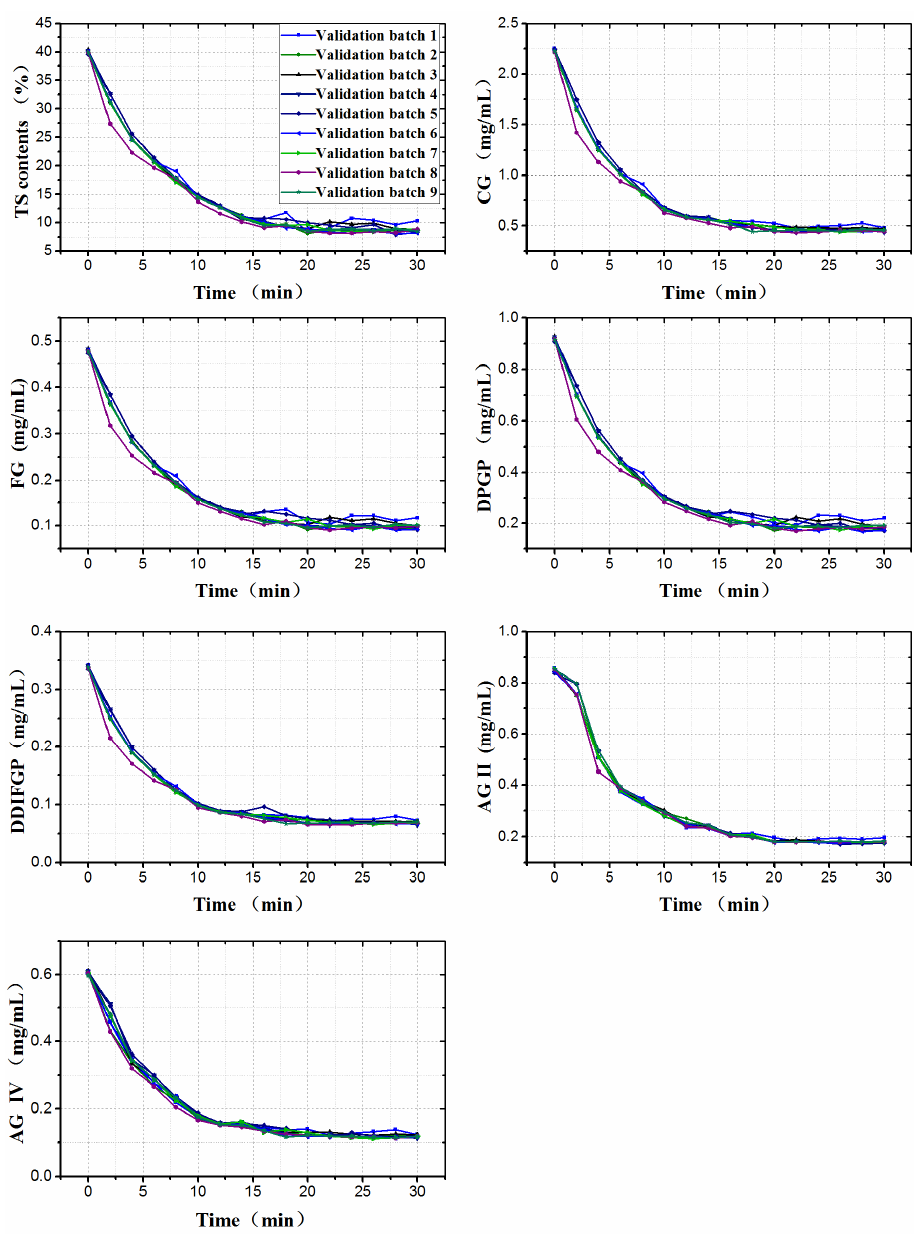
Figure 5. In-line monitoring results of 9 validation batches of the second alcohol precipitation. Table 5. Chemometric validation parameters for the 7 quantitative models.